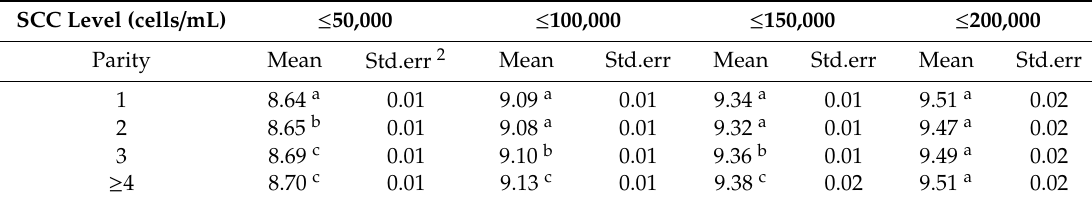
Table 5. P + LT 1 mean and standard error in healthy subset ranked by SCC levels. SCC Level (cells / mL) ≤ 50,000